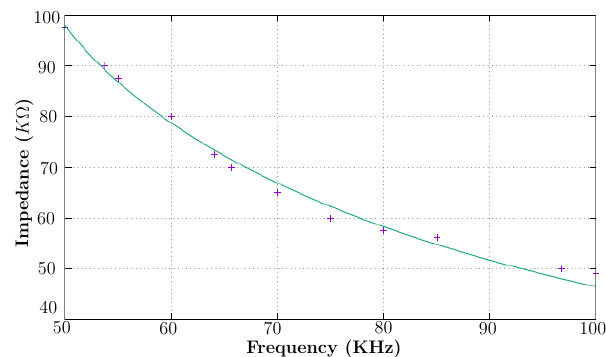
Figure 3. Frequency response of the modeled impedance data for a glucose concentration of 4.0 mmol/L from [8].